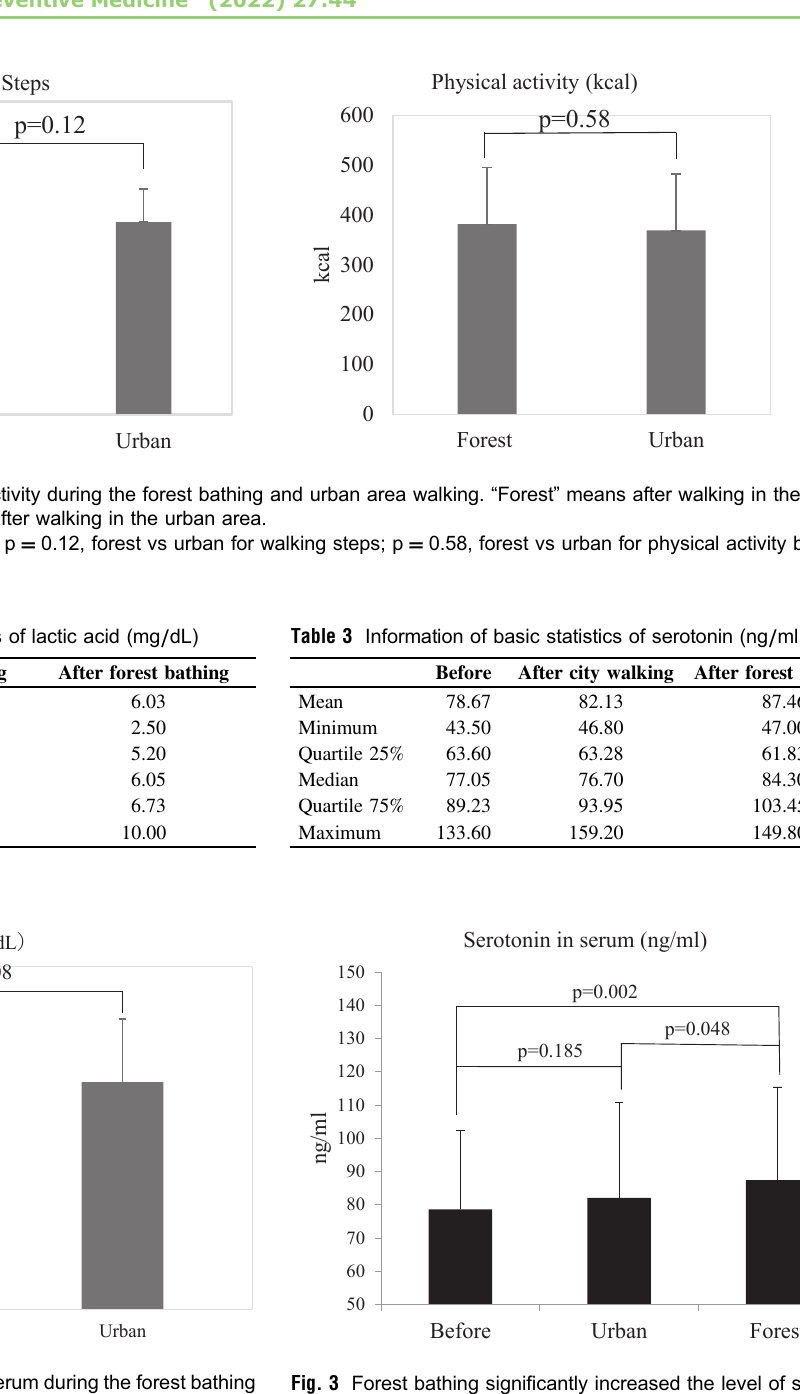
Fig. 3 Forest bathing signi fi cantly increased the level of serotonin in serum in male subjects. Data are presented with mean + SD, p = 0.002, forest vs before, p = 0.048, forest vs urban, p = 0.185 urban vs before by paired t-test (n = 20) “ Before ” means before the walking in the urban area or before the forest bating. “ Urban ” means after walking in the urban area. “ Forest ” means after walking in the forest (forest